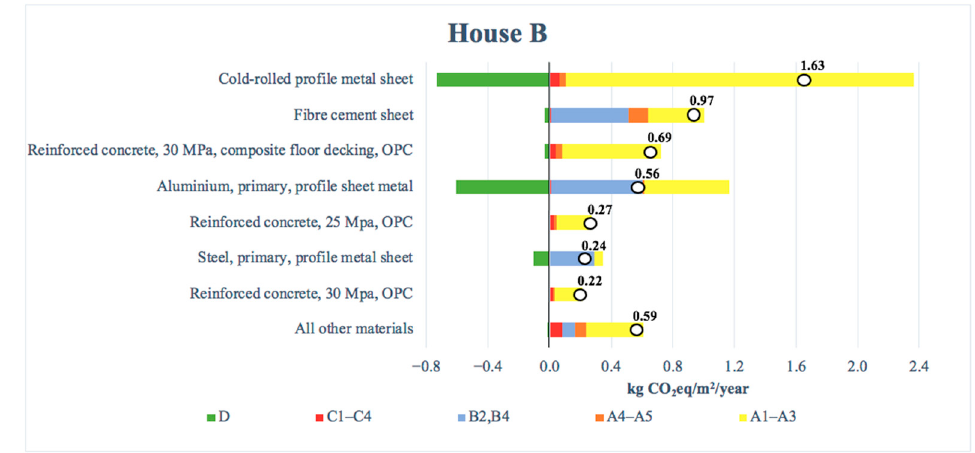
Figure 8. The amount of carbon emissions obtained from 7 different building materials for House